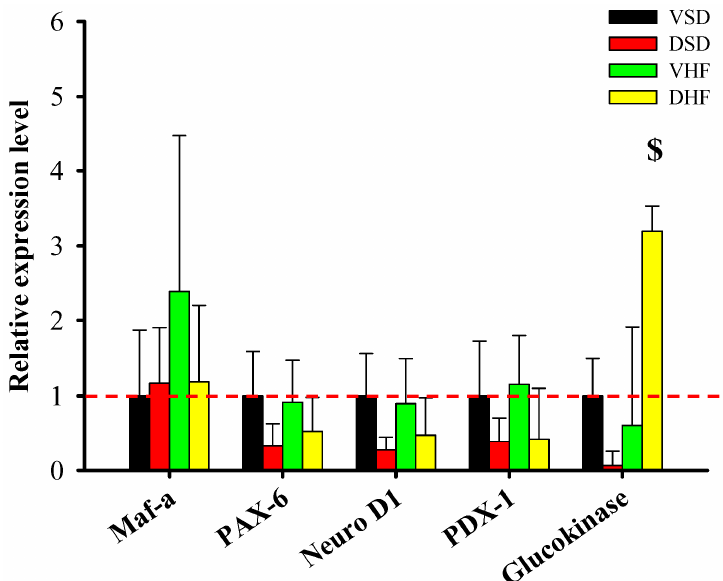
Figure 4. Pancreas mRNA transcript levels. The red dotted line represented that the relative gene expression was 1 when compared to VSD group. Maf-a, V-maf avian musculoaponeurotic fibrosarcoma oncogene homolog A; PAX-6, paired box gene 6; Neuro D1, neuronal differentiation 1; PDX-1, pancreatic and duodenal homeobox factor-1. Data were compared by two-way ANOVA with post hoc least significant difference followed by LSD tests. $, DSD vs. DHF, p < 0.05.